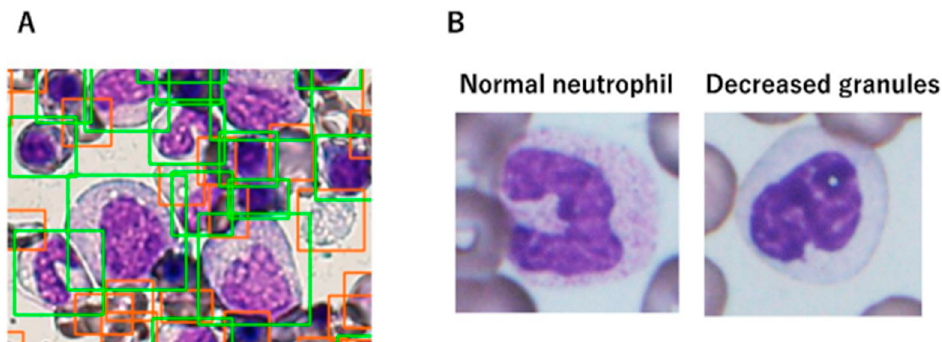
Figure 7. Detection of dysplasia by AI. (100 × ) ( A ) The detectors distinguish the cells of interest (green boxes include all nucleated cells and red boxes include red blood cells, platelets, and debris); ( B ) Normal mature neutrophil with adequate cytoplasmic granules ( left ) and granulocytic hypogranularity in a mature neutrophil ( right ). Adapted from Mori et al. [103] .